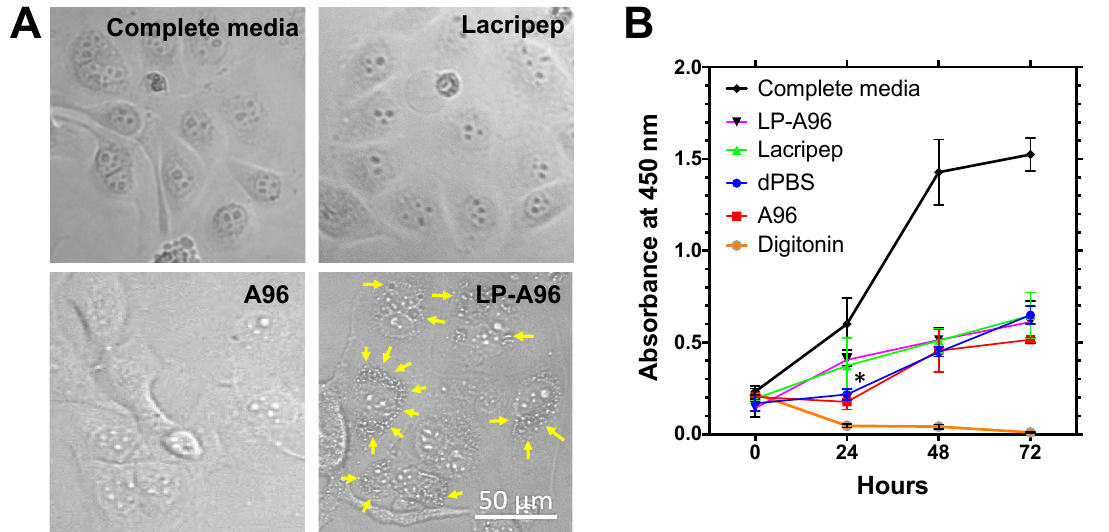
Figure 5. LP-A96-mediated exosome biogenesis does not affect cell viability in corneal epithelial cells. ( A ) Brightfield images of HCE-T cells at 48 h post-treatment. The appearance of LP-A96 treated HCE-T cells at 48 h was typical of that observed throughout the 3-day incubation period, while all other treatments did not affect the appearance of the cells. Yellow arrows indicate possible perinuclear compartments. ( B ) Cell viability upon 1 μ M LP-A96 treatment was quantified alongside other treatments. 50 μ M Digitonin was used as a cytotoxic agent. All experiments were performed when cells were subconfluent (30%). At 24 h, LP-A96 vs. A96 treatment: p = 0.012*; LP-A96 vs. dPBS: p = 0.052. A one-way ANOVA followed by multiple comparisons was used for statistical comparison. * p < 0.05. Mean ± SD.